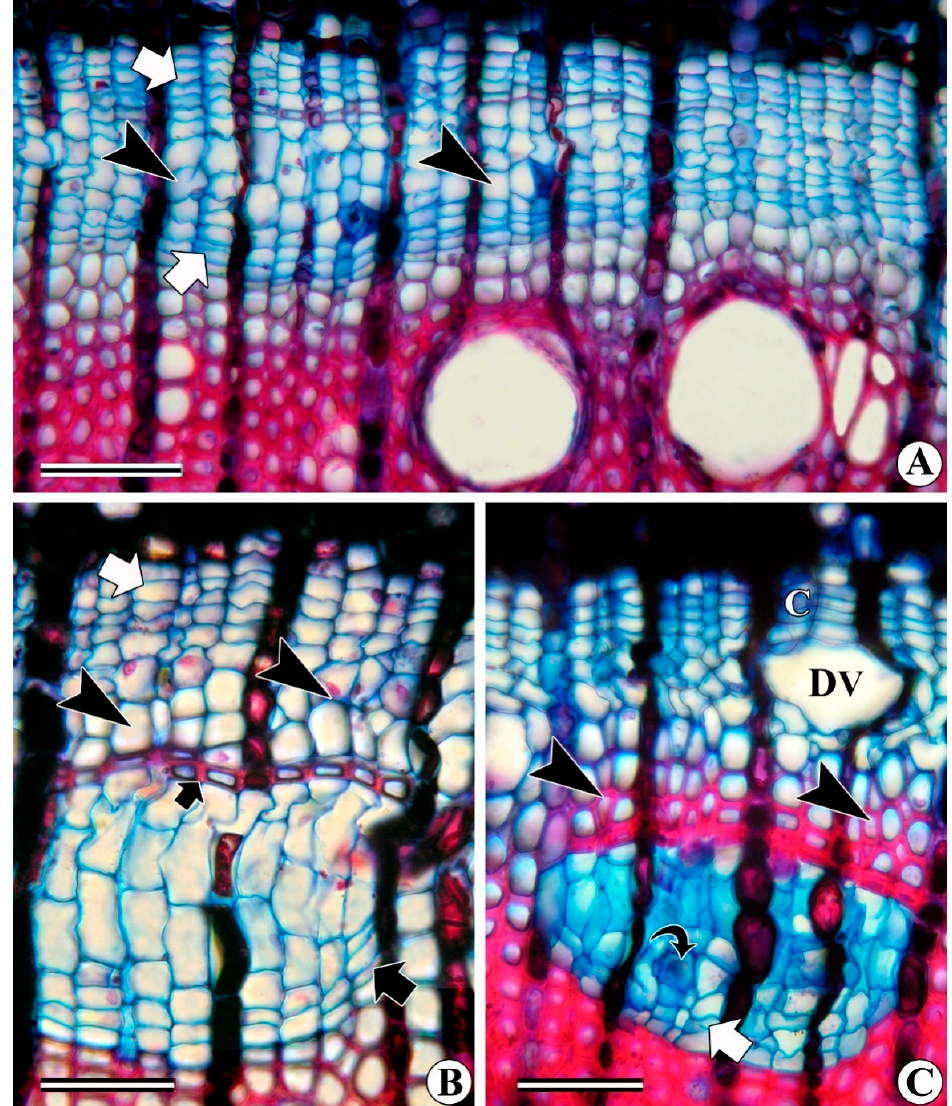
Figure 6. Transverse view of Calycopteris floribunda stems showing the development of interxylary phloem. ( A ) Initiation of separation of the cambium into outer and inner strips (arrows). Note the cambial zone from the left corner of the image to the right showing all the stages of cambium separation. Arrowheads indicate differentiating xylem derivatives. ( B ) Widely separated outer and inner cambial segments (arrows) and differentiating thin-walled xylem derivatives (arrowheads). Note that cambial cells transformed into thick-walled xylem derivatives (small arrow). ( C ) Initiation of deposition of lignified elements (arrowhead) and inclusion of the separated cambium along with the phloem within the secondary xylem. The curved arrow indicates the differentiating sieve element. Arrow indicates radially arranged meristematic (cambium) cells. Abbreviations : C = cambium, DV = differentiating vessel. Scale bars: A = 100 µm; B, C = 50 µm.